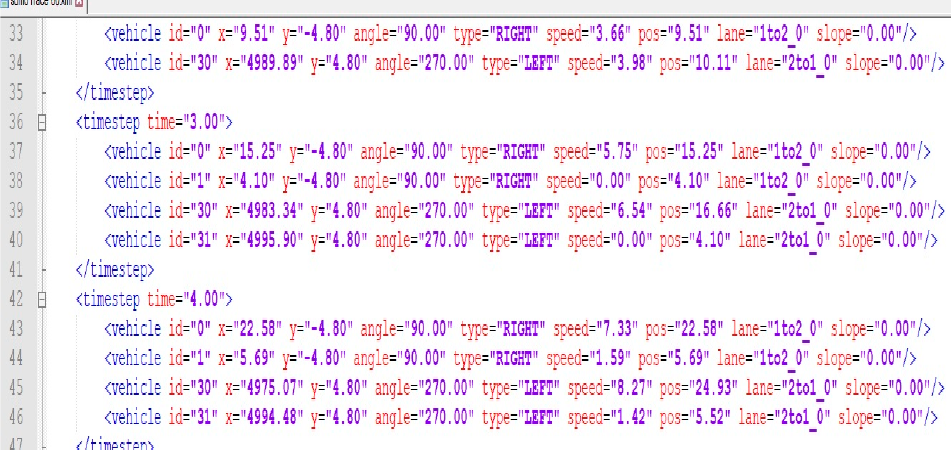
Figure 9. Snapshot of the dataset file. Table 4. Simulation scenarios.